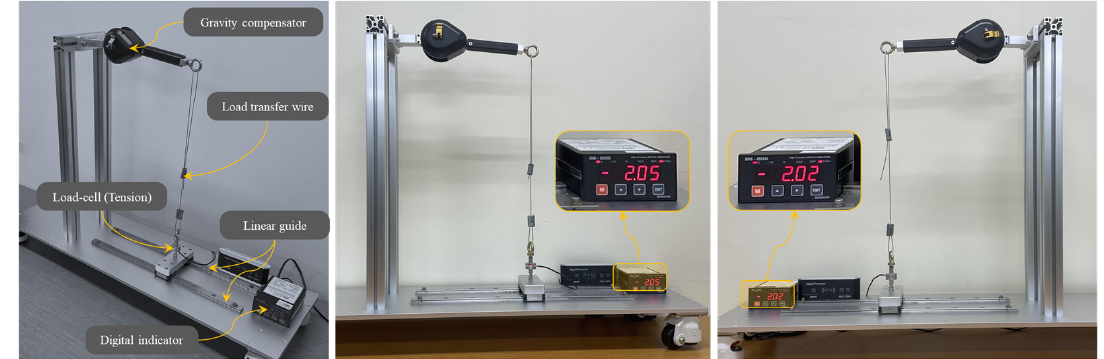
Figure 13. Test set-up and instruments for the generated torque test of the gravity compensation module. Table 2. The results of the generated torque test of the gravity compensation module.